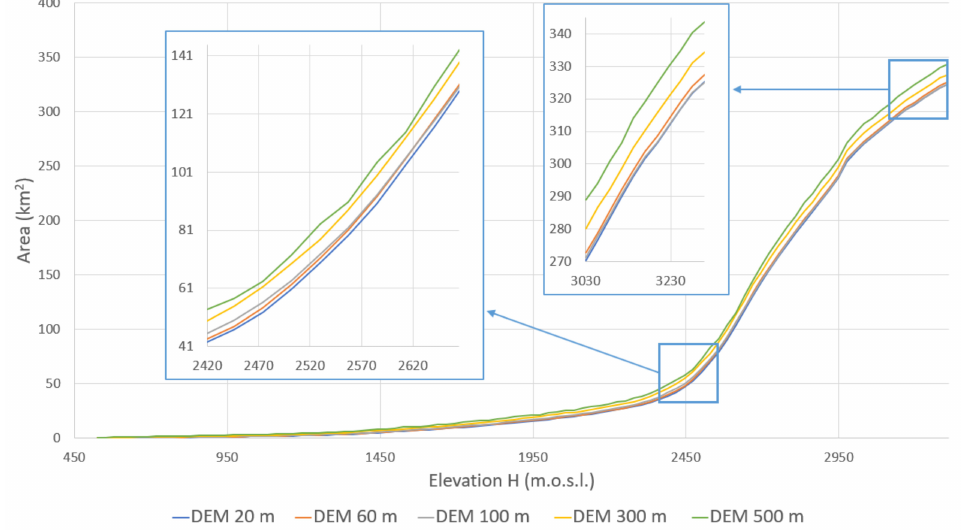
Figure 6. Hypsometric curves at 20, 60, 100, 300 and 500 m digital elevation model (DEM) resolution for Moio Alcantara